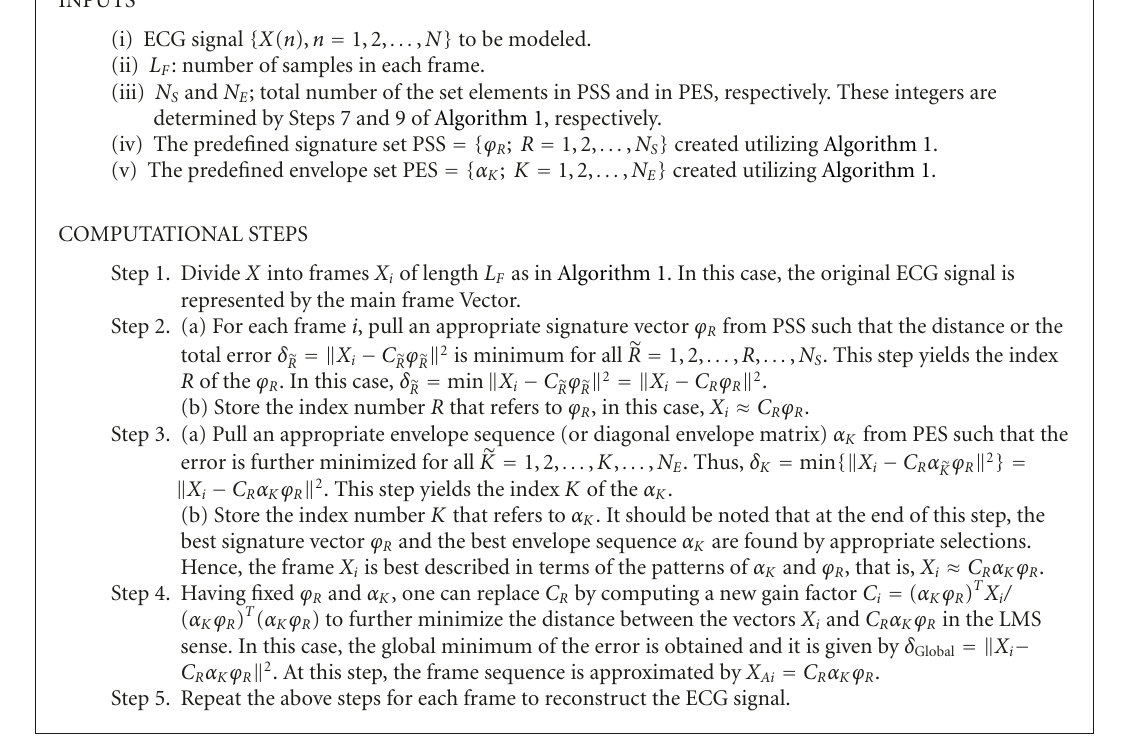
Algorithm 2: Reconstruction of ECG signals by using PSEVS.